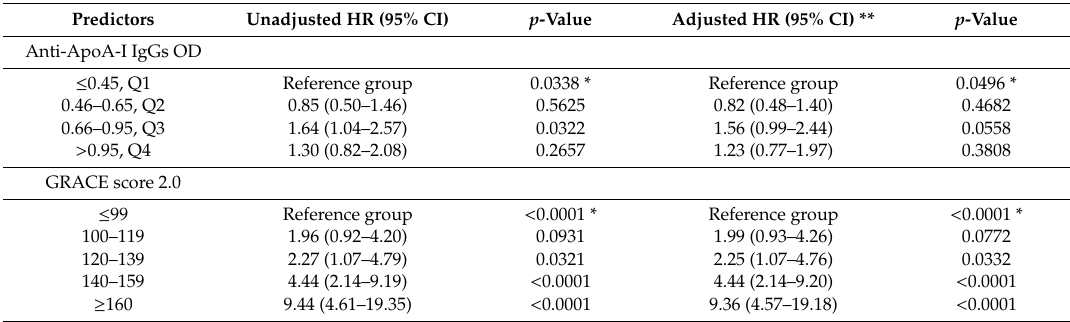
Figure 1. Cumulative incidence of major adverse cardiovascular events (MACE) (myocardial infarction, stroke, TIA, or cardiovascular (CV) death) according to autoantibodies against